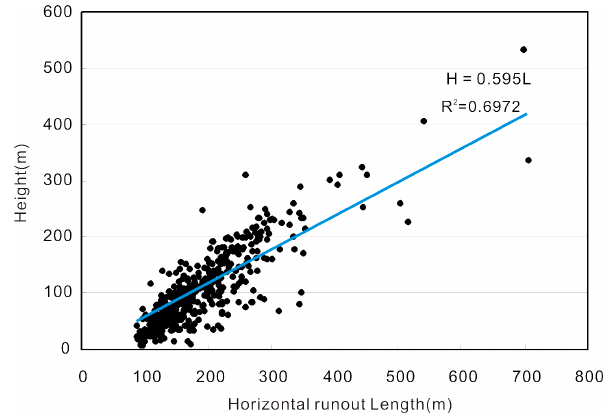
Figure 15. Relationship between landslide height and horizon- tal runout length. A total of 453 landslides of area larger than 10000m 2 triggered by the Haiti earthquake were used to carry out the